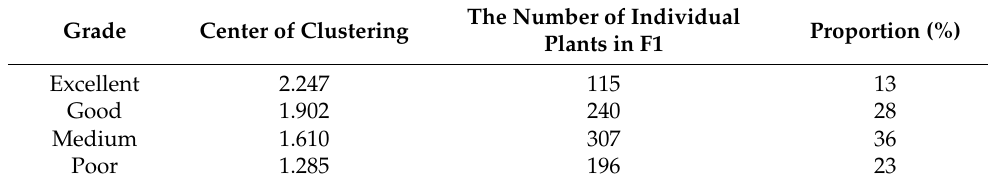
Table 12. Grading result of individual